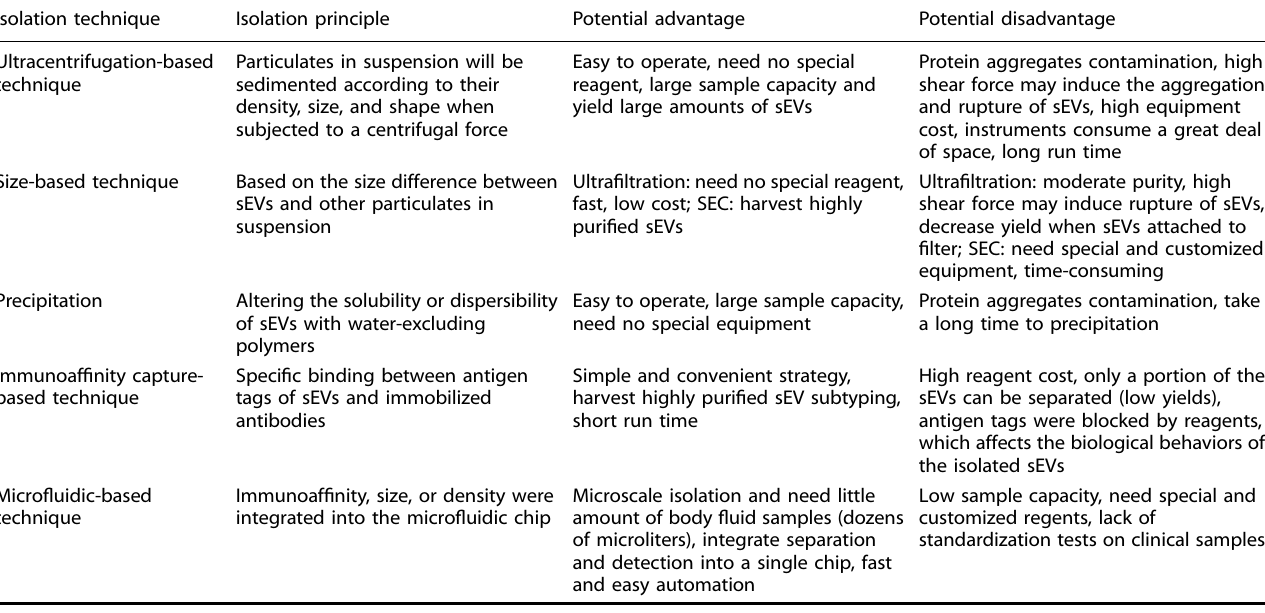
Table 1. The current isolation techniques for sEVs.